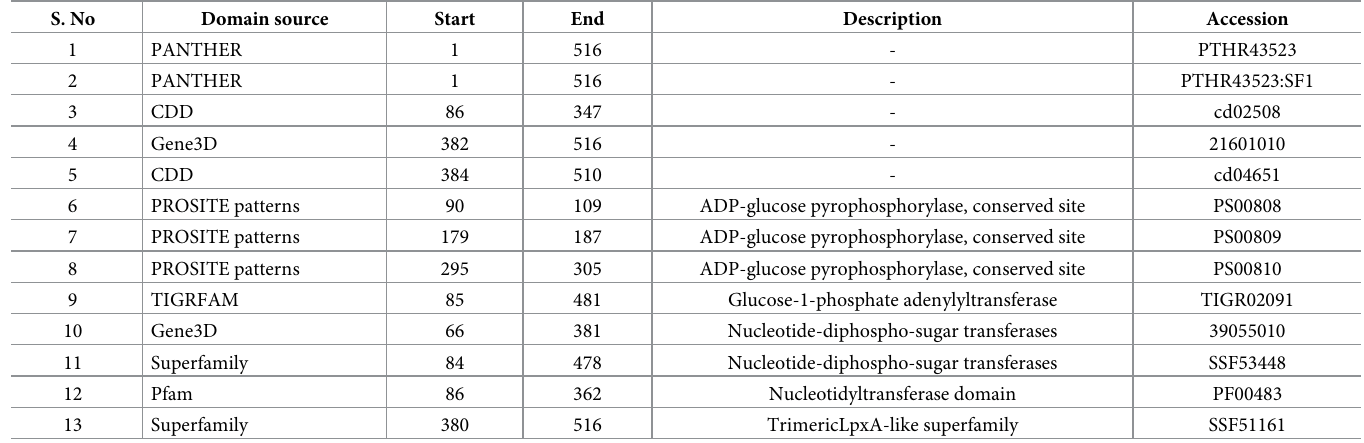
Table 4. Domains and features of SH2 protein in Zea mays